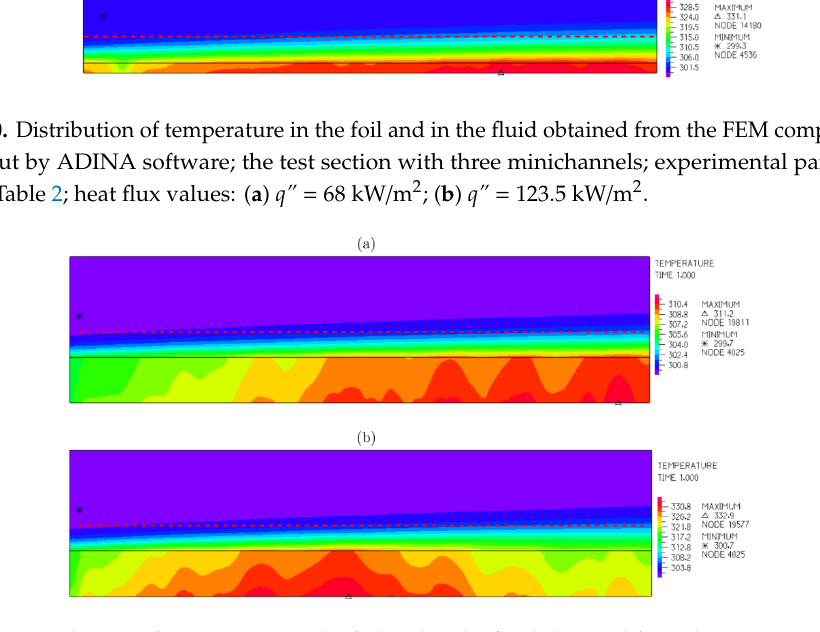
Figure 11. Distribution of temperature in the foil and in the fluid obtained from the FEM computations carried out by ADINA software; the data for the test section with five minichannels; experimental parameters listed in Table 2, heat flux values: ( a ) q” = 13.8 kW / m 2 ; ( b ) q” = 55.8 kW / m 2 .